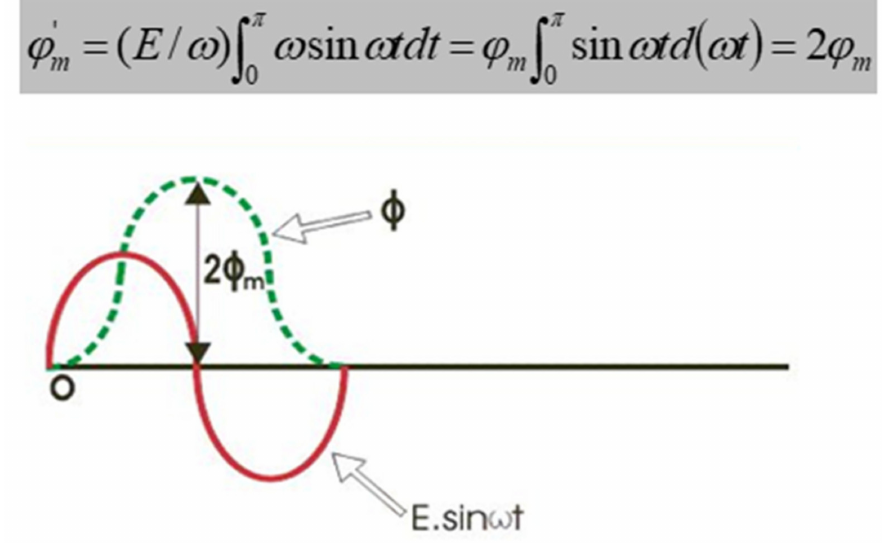
Figure 6. Transformer flux doubling